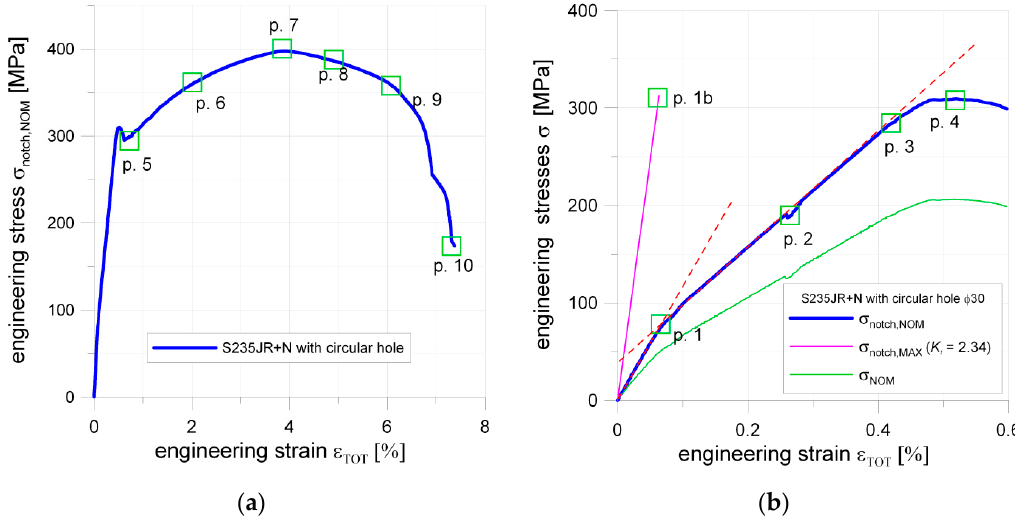
Figure 10. Tensile behavior of S235JR + N: ( a ) engineering σ – ε curve for plate with circular hole; and ( b ) magnified initial part of the curve.